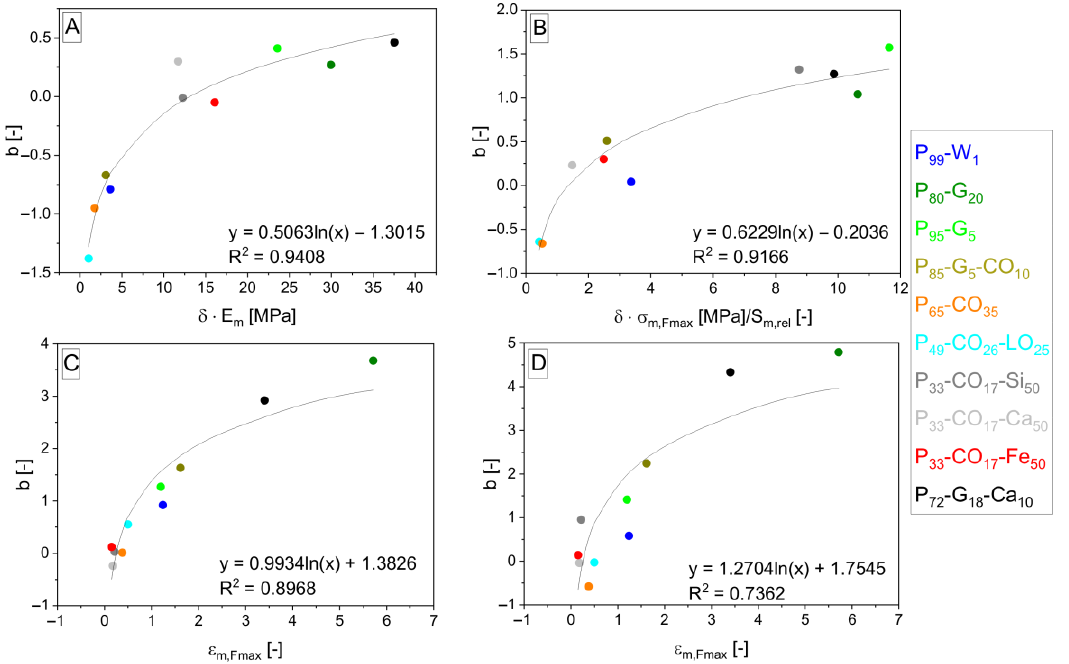
Figure 8. Logarithmic dependencies y = d + e · ln x of parameters b from general Equation (11) with different b values according to specification of property z into E ( A ), σ Fmax ( B ), ε Fmax ( C ), and A Fmax ( D ) interpolated by δ · E m ( A ), δ · σ m,Fmax /S m,rel ( B ), and ε m,Fmax ( C , D ) values from Table 1 ( δ ), Equation (20) ( S m,rel ), and Table 4 (the others). The resulting dependencies correspond to exponent d + e · ln x in Equations (16) – (19) arising from Equation (11) in the order from ( A ) to ( D ).